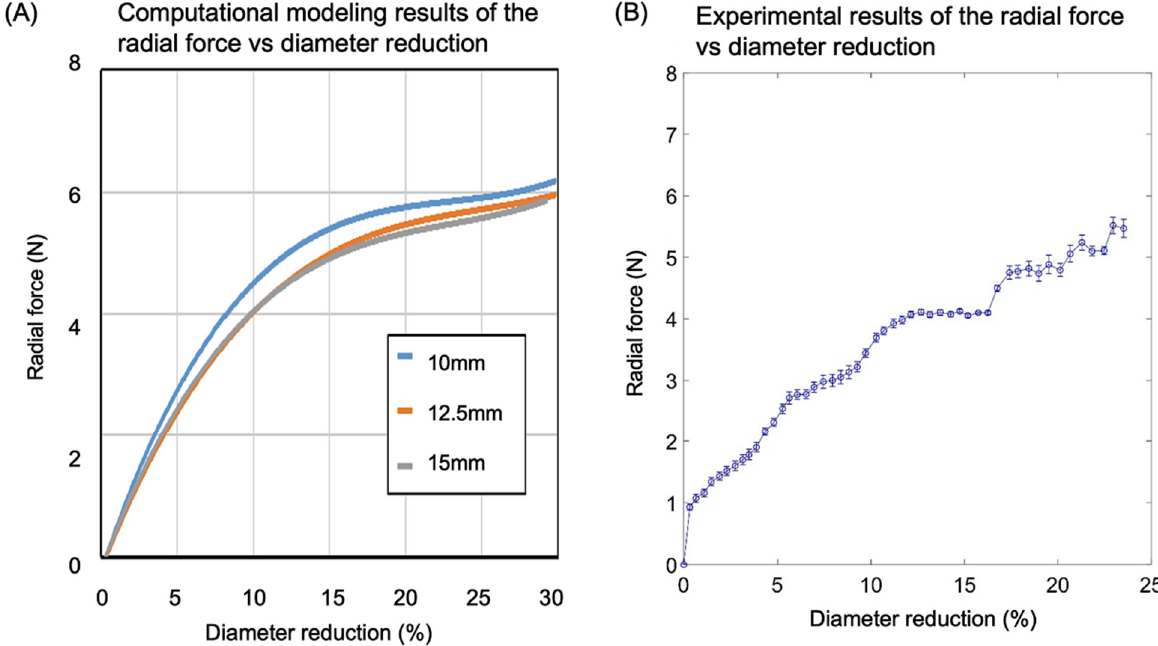
Figure 11. Computational ( A ) and experimental ( B ) results of the radial force (N) vs. diameter reduction (%) for the varied valve diameters.